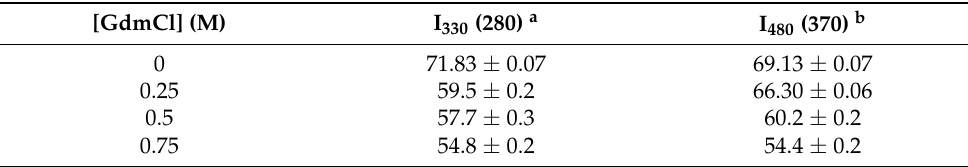
Table 3. Apparent thermal unfolding temperatures (in ◦ C) of bsHPrK/P at different GdmCl concen-